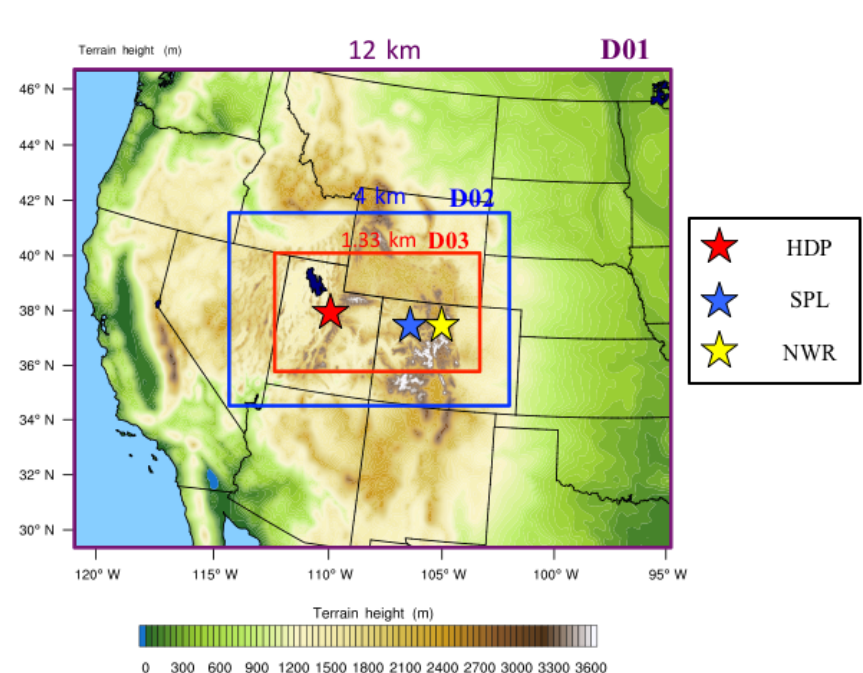
Figure 2. The WRF simulation domain, covering the western US with a series of nests with 12, 4, and 1.3km grid spacing. These WRF meteorological fields are used to drive air parcel trajectories within the STILT